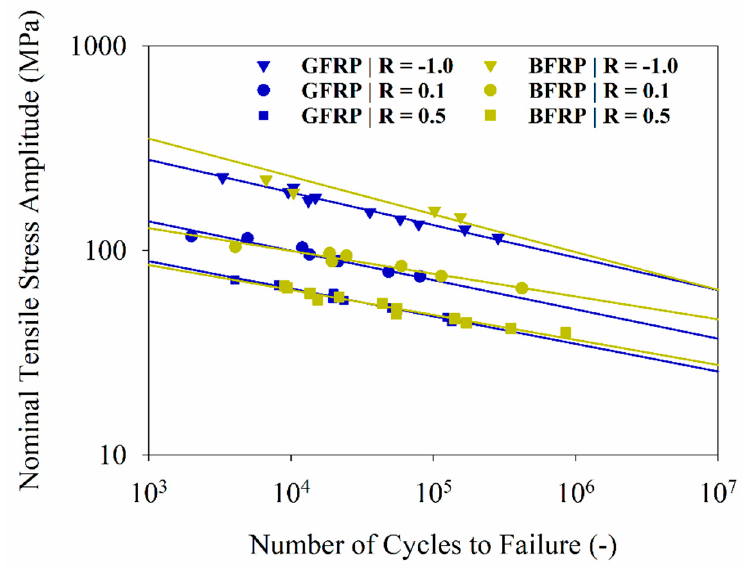
Figure 4. Fatigue testing results of basalt fiber (BFRP) and glass fiber (GFRP), SN curves for R = − 1.0, 0.1 and 0.5.